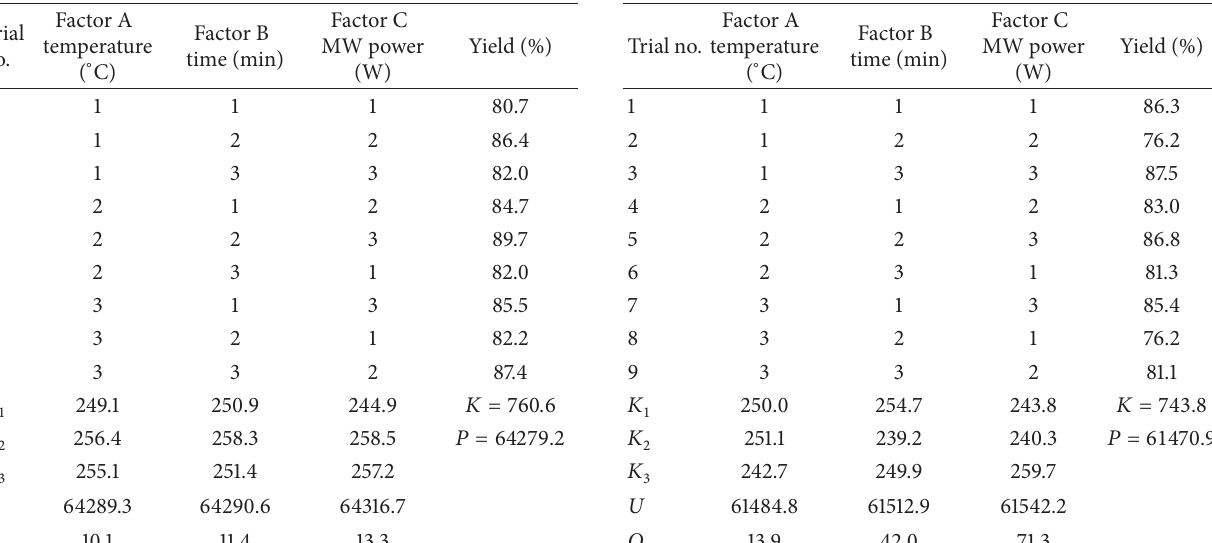
Table 2: Orthogonal experiments on synthesis of 2-methyl-4-(3,4- acetoxybenzylene)oxazol-5-ones.